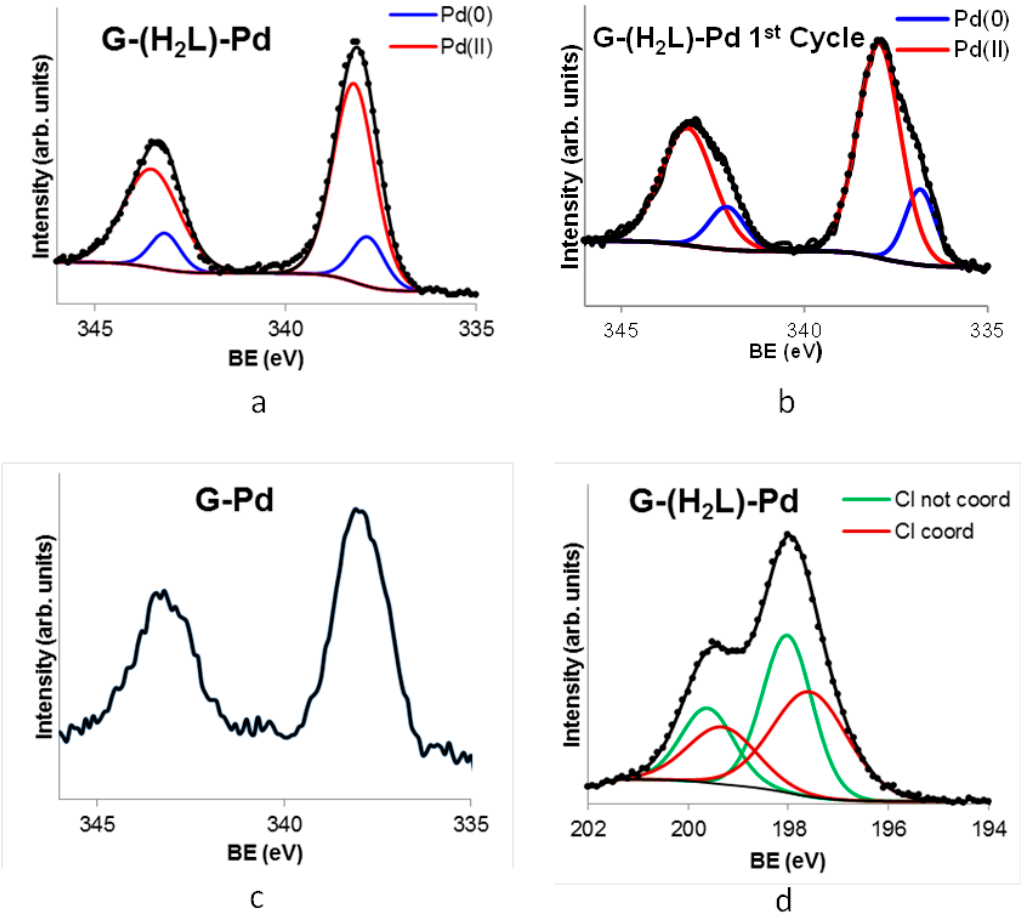
Figure 9. High-resolution XPS spectra of G-(H 2 L)-Pd: fresh ( a ) and after the first reaction cycle ( b ), of G-Pd in the Pd 3d 5 / 2 and Pd 3d 3 / 2 regions ( c ) and spectra of G-(H 2 L)-Pd in the Cl 2p 3 / 2 and Cl 2p 1 / 2 regions ( d